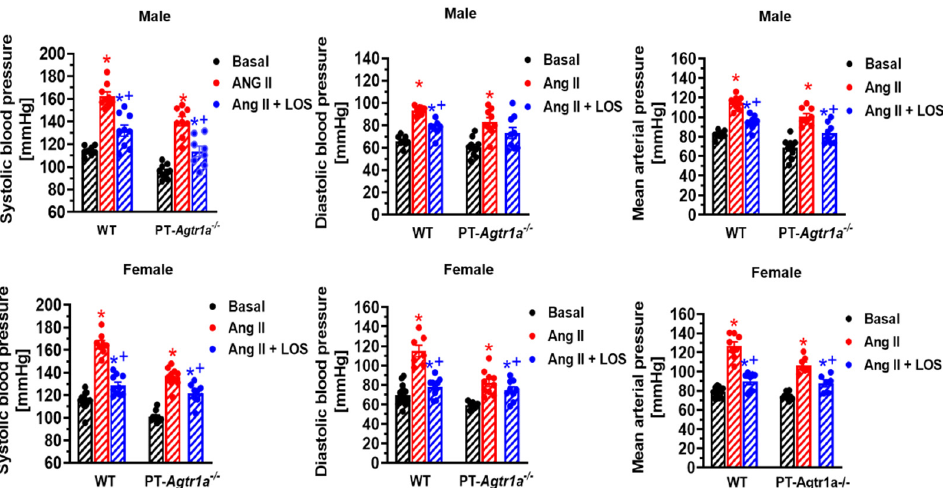
Figure 4. Basal systolic, diastolic, and mean arterial blood pressure and in response to osmotic minipump infusion of a high pressor dose of Ang II with or without AT 1 (AT 1a ) receptor blocker losartan for two weeks in adult male and female wild-type and PT- Agtr1a -/- mice. Note that deletion of AT 1a receptors selectively in the proximal tubules significantly decreased basal blood pressure by ~13–15 ± 3 mmHg similarly in male and female PT- Agtr1a -/- mice under basal conditions. In addition, Ang II-induced hypertension was significantly attenuated in both male and female PT- Agtr1a -/- mice. * p < 0.05 vs. control WT or PT- Agtr1a -/- mice; + p < 0.05 vs. Ang II-infused male or female wild-type or PT- Agtr1a -/- mice. Reproduced from Reference [12] with permission.